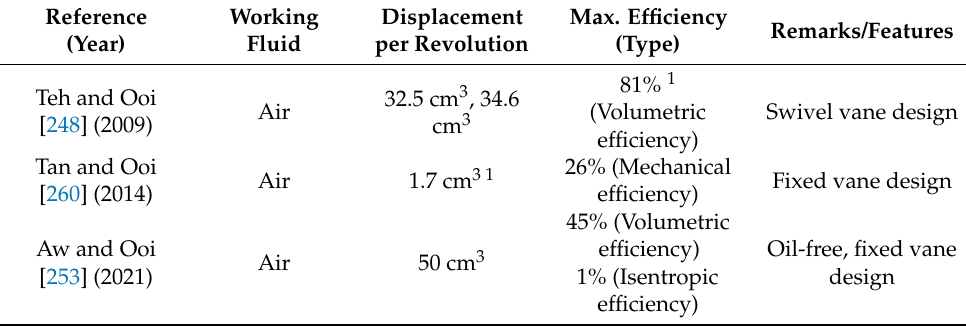
Table 8. Synchronal rotary/revolving vane compressor